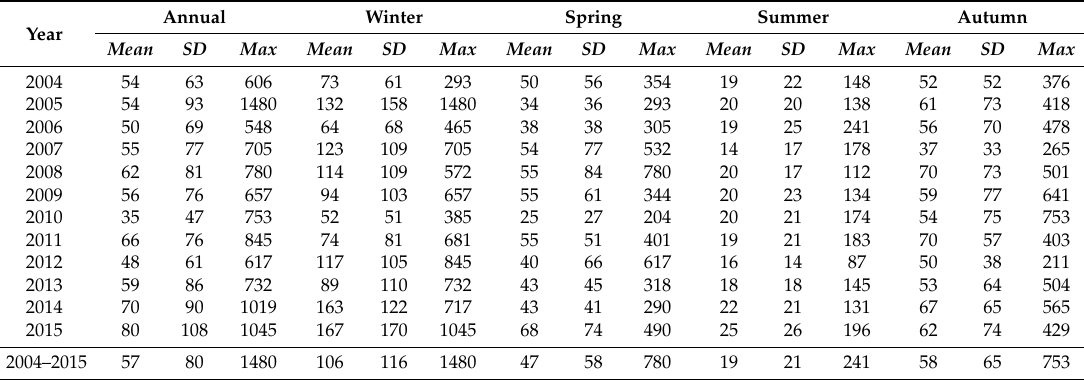
Table A10. Summary statistics from annual and seasonal analyses of P (kW/m) at BB.